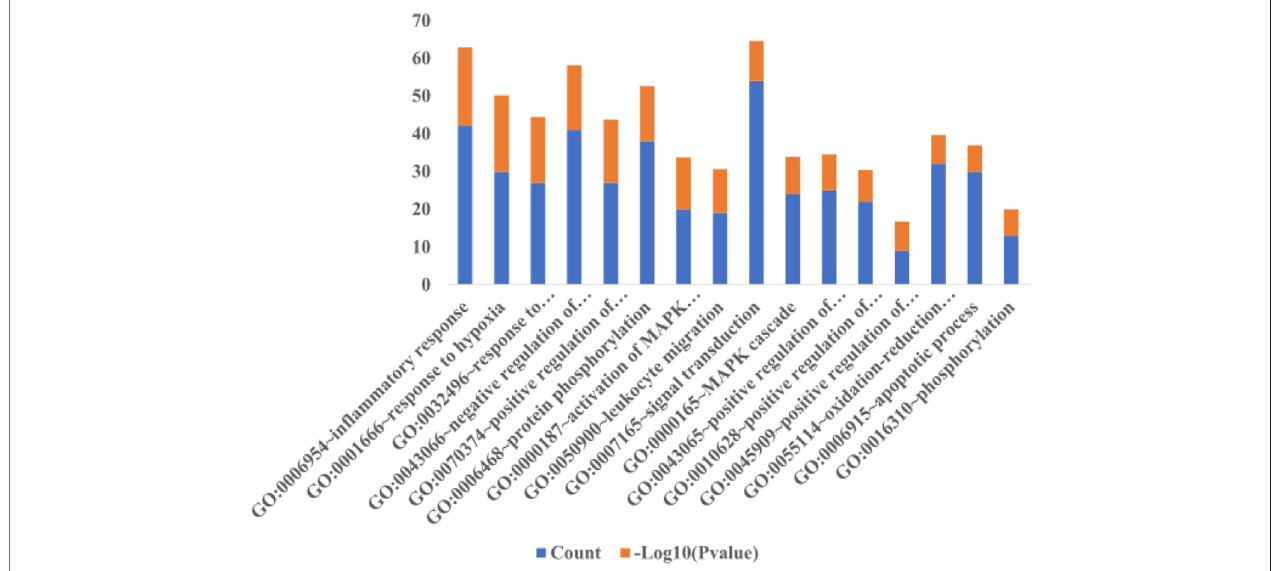
FIGURE 8 | Biological process. When the screening conditions of p < 0.01 and FDR < 0.05 were set, 337 BP enriched datasets were obtained from 291 intersection target genes in DAVID database, and only 16 major BP results are shown in this fi gure.